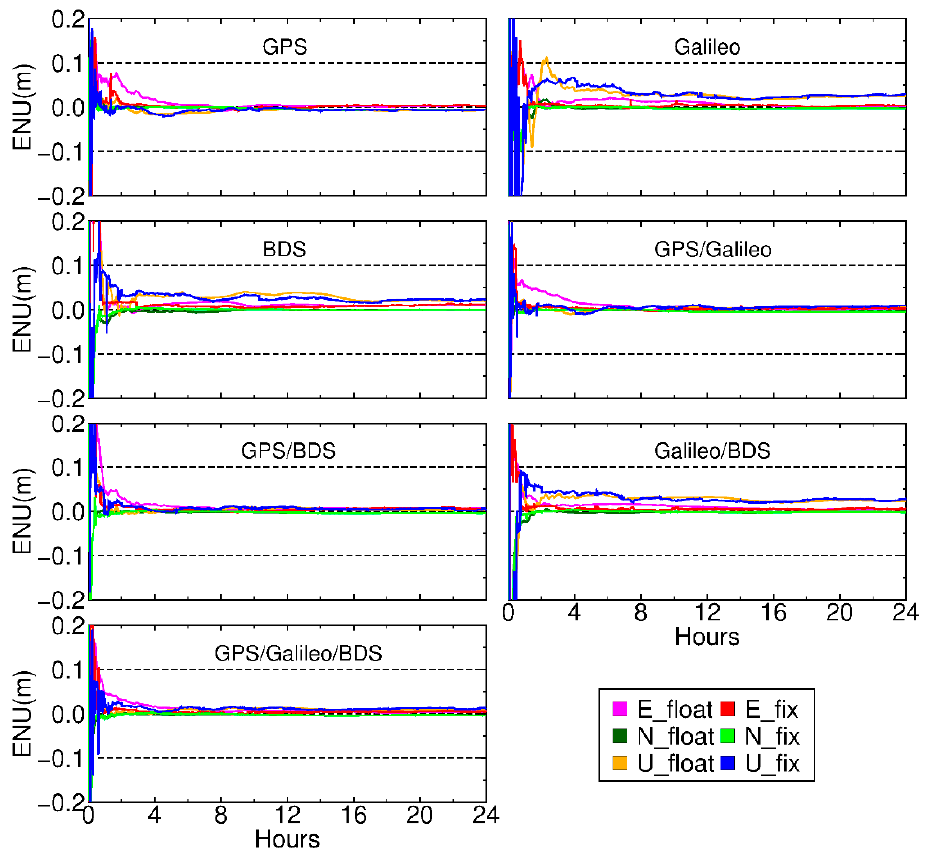
Figure 10. Comparison of the float and fixed PPP results from single-system and combined solutions in the E, N, and U components, respectively, at station KAT1 on DOY 324, 2018.